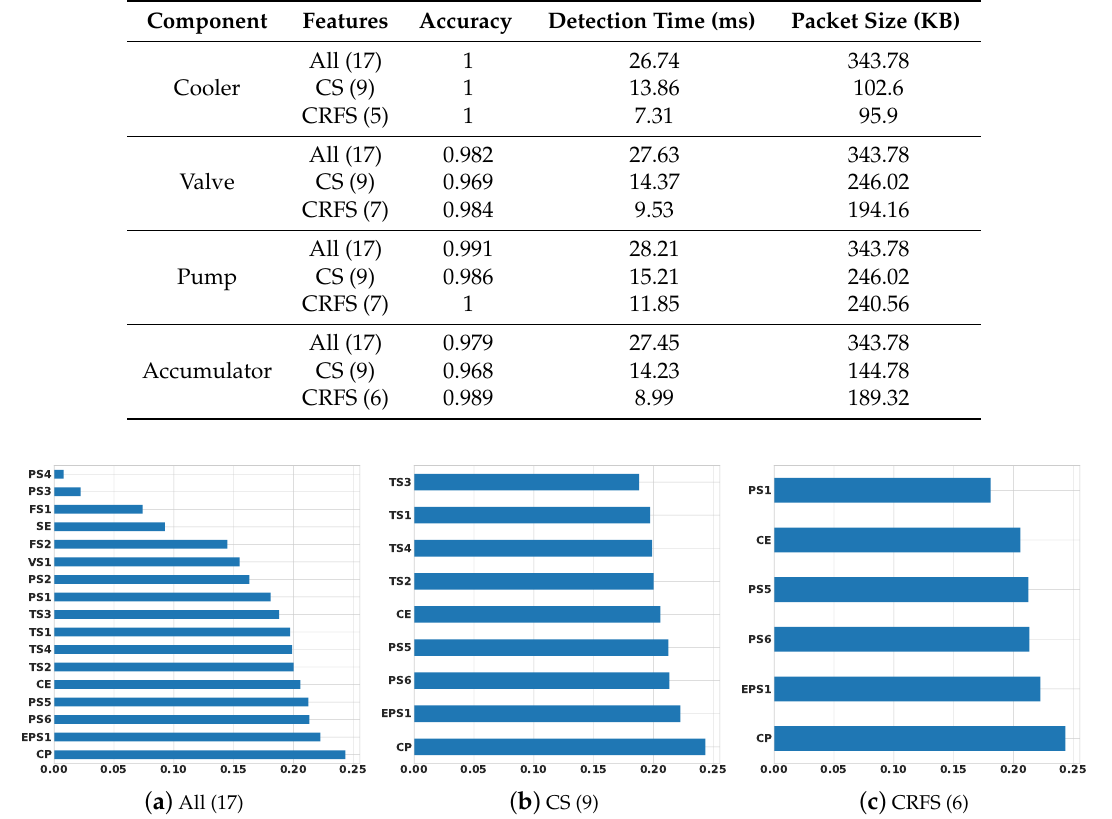
Table 7. Performance of feature selection.